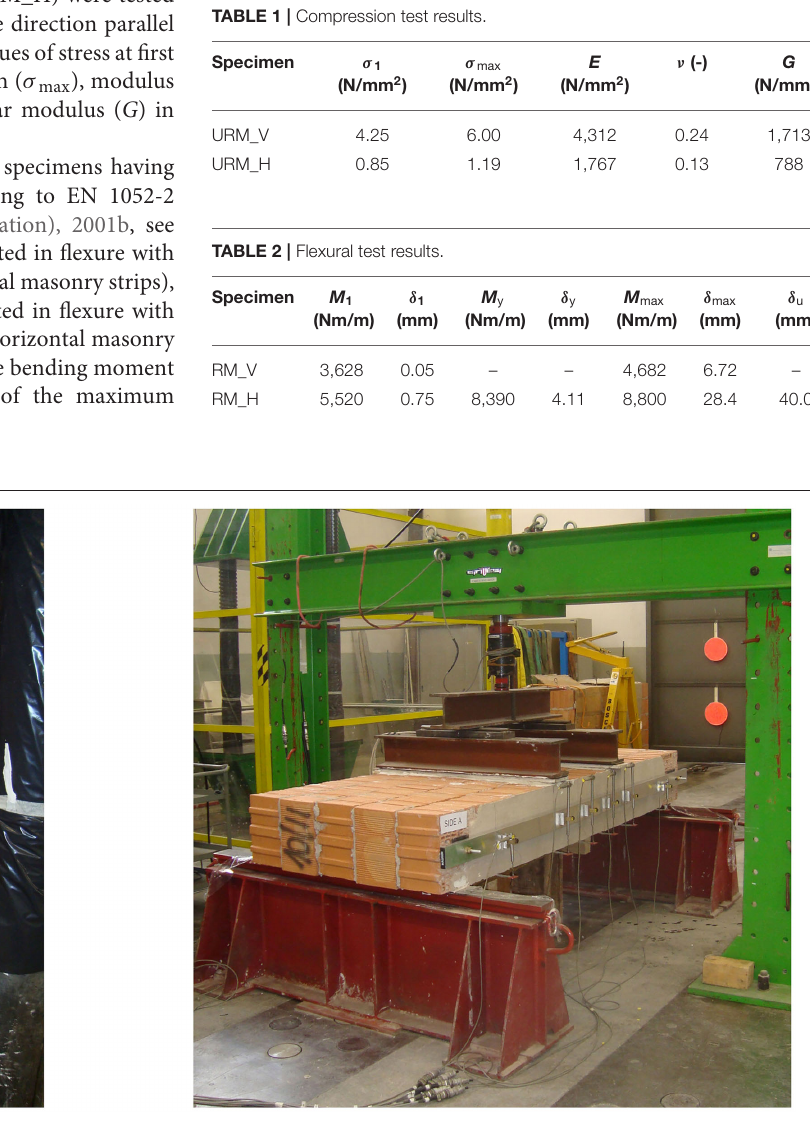
FIGURE 2 | View of compression test (vertical loading, left); view of flexural test (failure line orthogonal to bed joints, right).